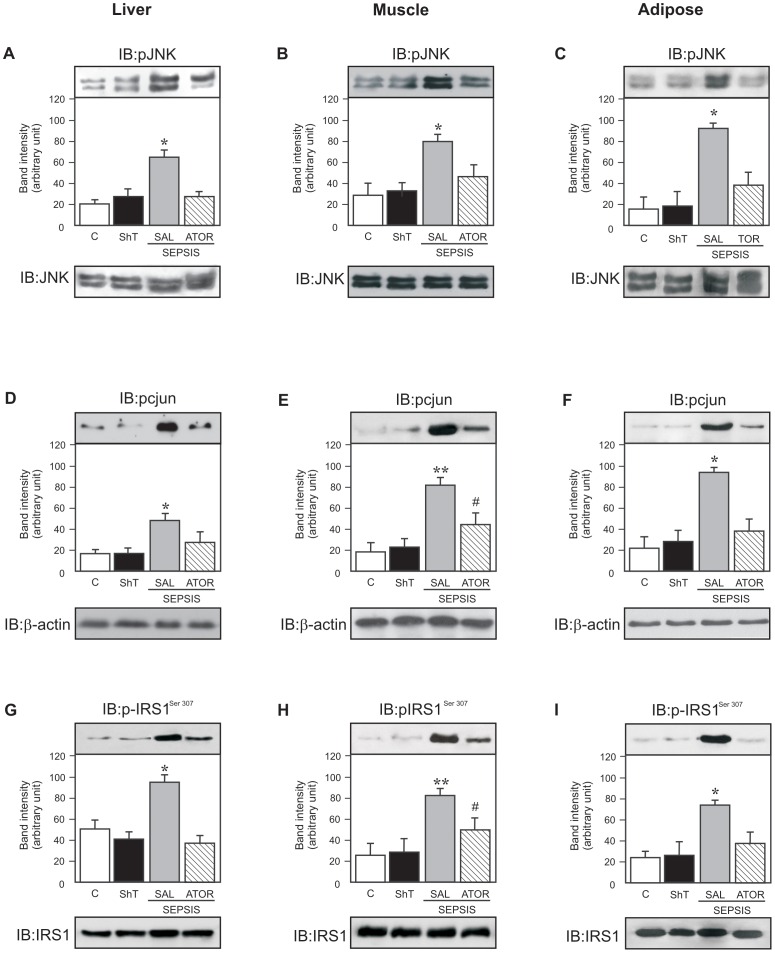
Representative blots show the JNK phosphorylation in liver (A), muscle (B) and adipose tissue (C) of sham and septic rats (upper panels).Total protein expression of JNK (A–C, lower panels). Phosphorylation of c-jun in liver (D), muscle (E) and adipose tissue (F) of sham and septic rats. Serine 307 Phosphorylation of IRS1 in liver (G), muscle (H) and adipose tissue (I) of sham and septic rats (upper panels). Total protein expression of IRS-1 (G–I, lower panels). Data are presented as means ± S.E.M from 6–8 rats per group. *P<0.05 (Sepsis/Sal vs. all others groups); **P<0.001 (Sepsis/Sal vs. control); #P<0.05 (Sepsis/Sal vs. Sepsis/Ator). IB, immunoblot; CLT: Sham/Saline; ShT: Sham/Atorvastatin; SAL: saline; ATOR: atorvastatin.